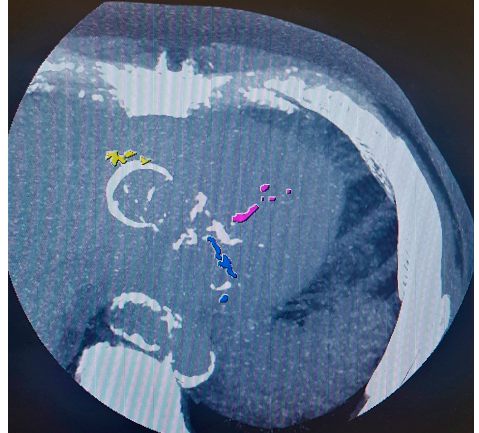
Figure 1. Coronary artery calcium scoring in an asymptomatic 43-year old HIV-positive male patient. Maximum intensity projection depicts extensive calcifications in the left anterior descending artery (purple), in the left circumflex artery (blue), and in the right coronary artery (yellow). The total Agatston score was 1031, classifying this patient as at high risk for future CV events and prompting lifestyle interventions and the initiation of a